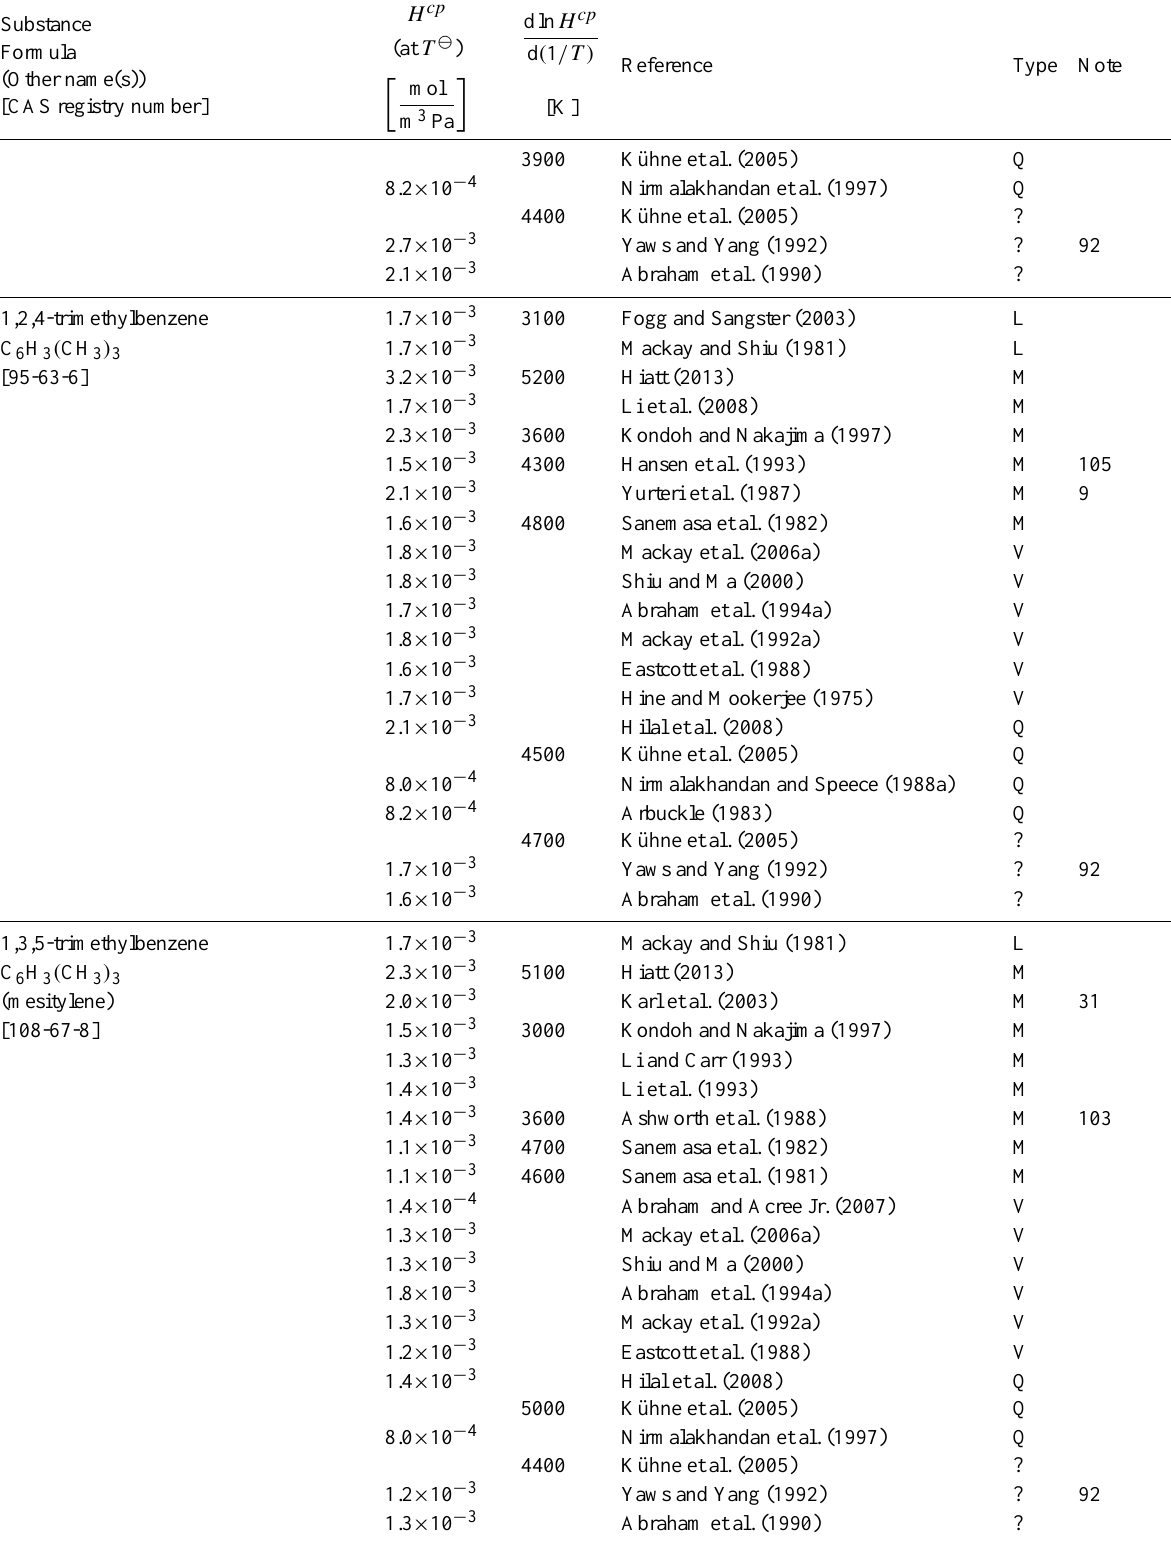
Table 6: Henry’s law constants for water as solvent